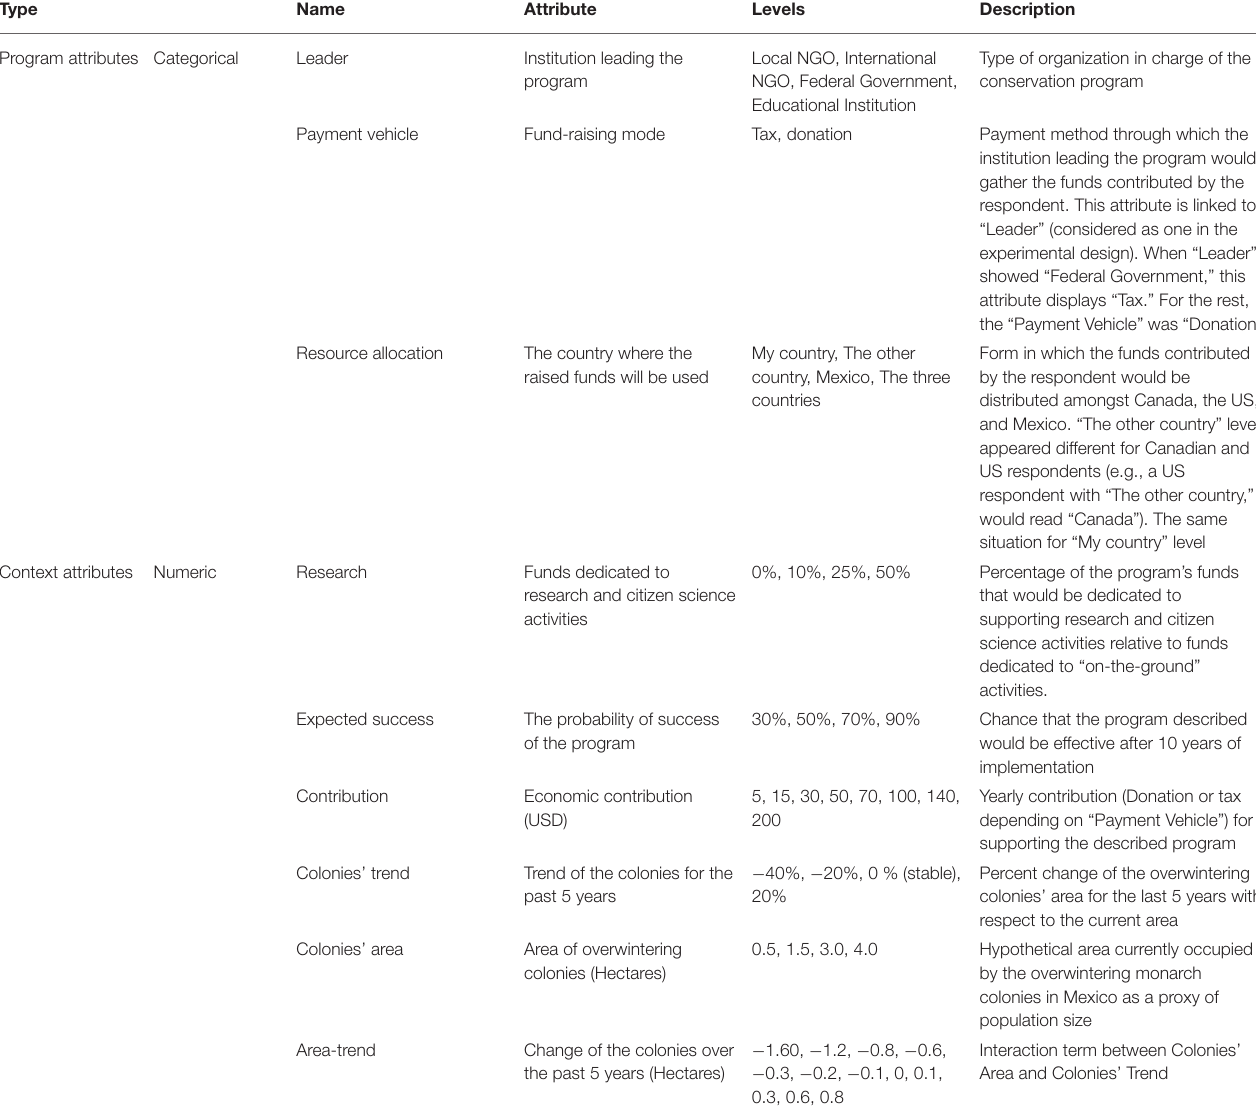
TABLE 3 | Attributes and levels used in the choice experiment